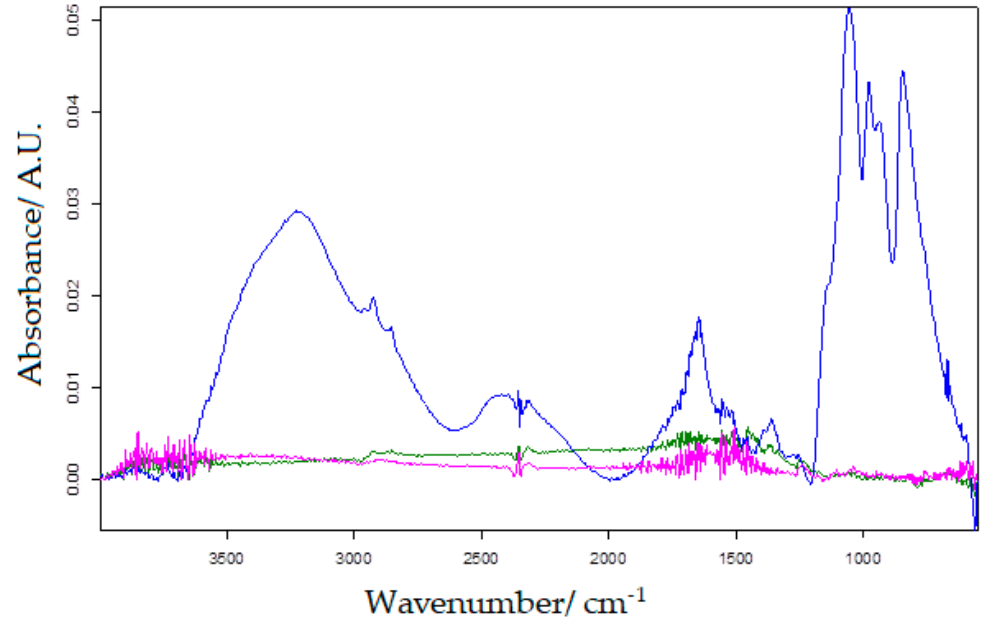
Figure 4. FTIR for SPE-C (pink line), SWCNT-SPE (green line) and SPE-SWCNT-Ty (blue line).